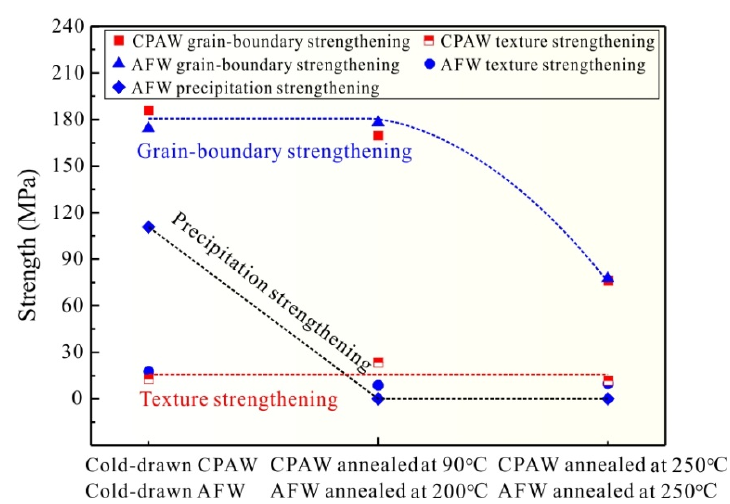
Figure 9. The strengths induced by the grain strengthening, the precipitates and the texture of the cold-drawn CPAW, the annealed CPAWs, the cold-drawn AFW and the annealed AFWs.